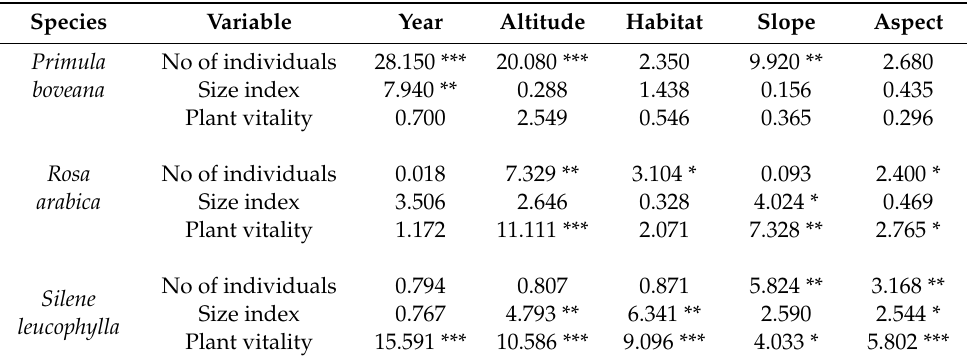
Table 2. Results of one-way ANOVA (F-values) showing the e ff ects of year, altitude, habitat, slope, and aspect on population size, plant size, and vitality of three endemic species in the Saint Katherine Protectorate Mountains.